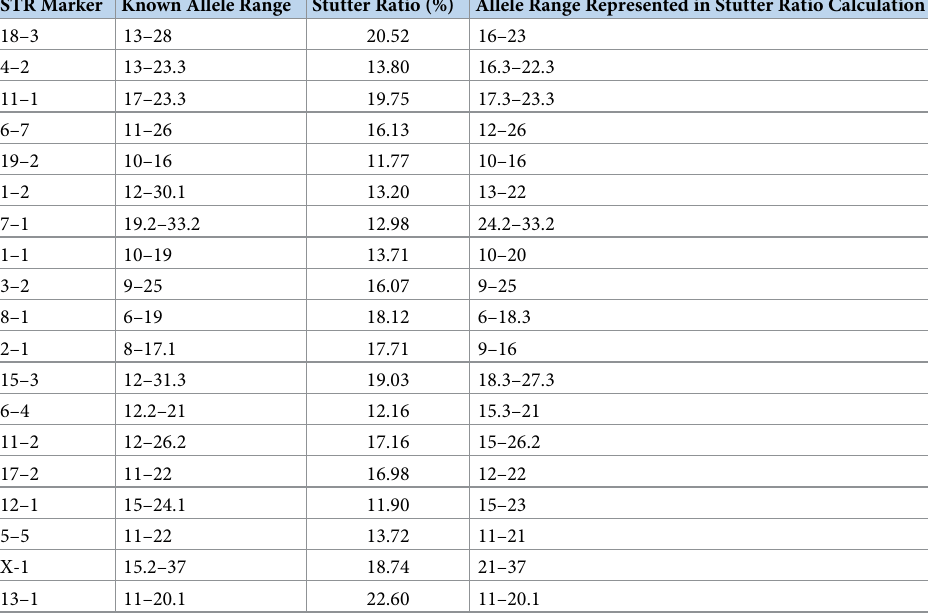
Table 2. Marker-specific stutter filter